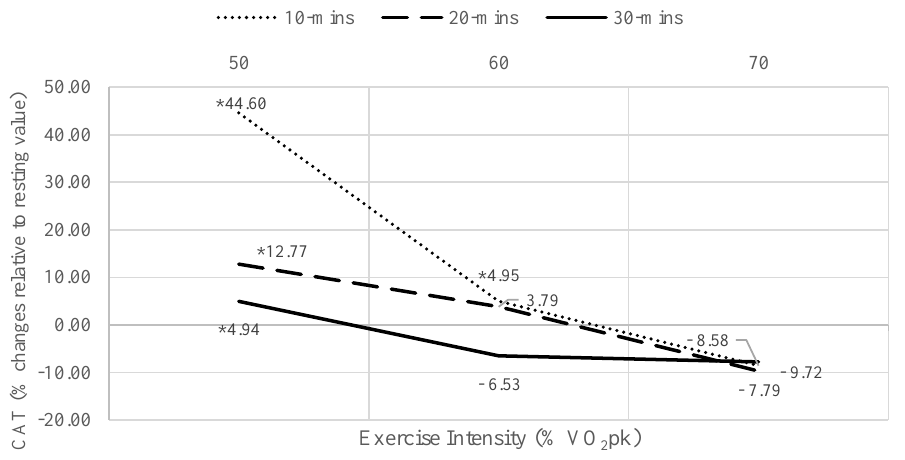
. VO 2 pk during exercise. * significantly